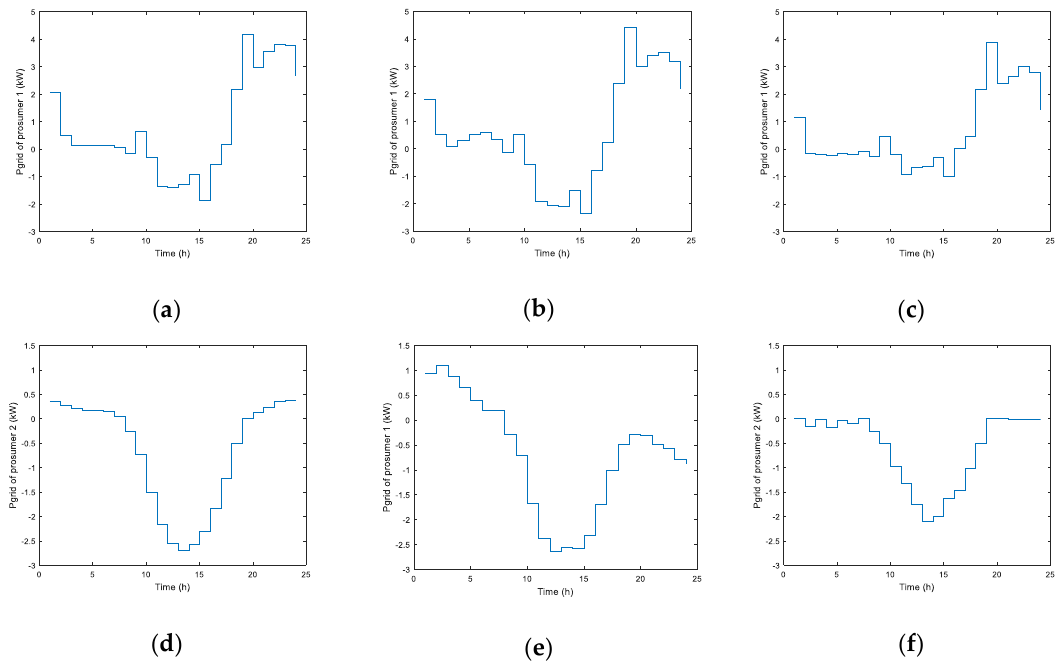
Figure 5. P grid during scheduled 24 h (positive values for import energy flow and negative for export):